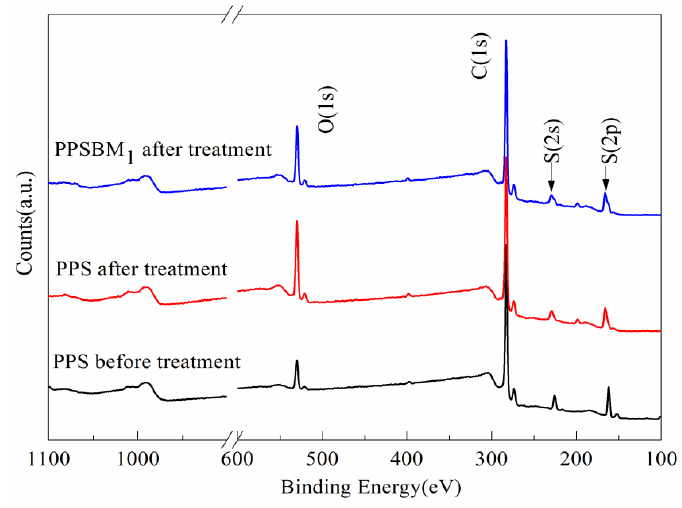
Figure 8. XPS spectra of PPS and PPSBM 1 composites after treatment.